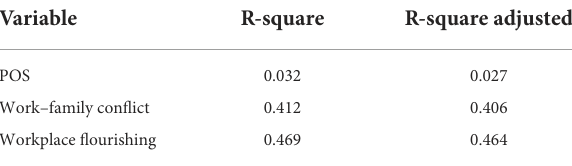
TABLE 6 R-squared. TABLE 7 Specific indirect